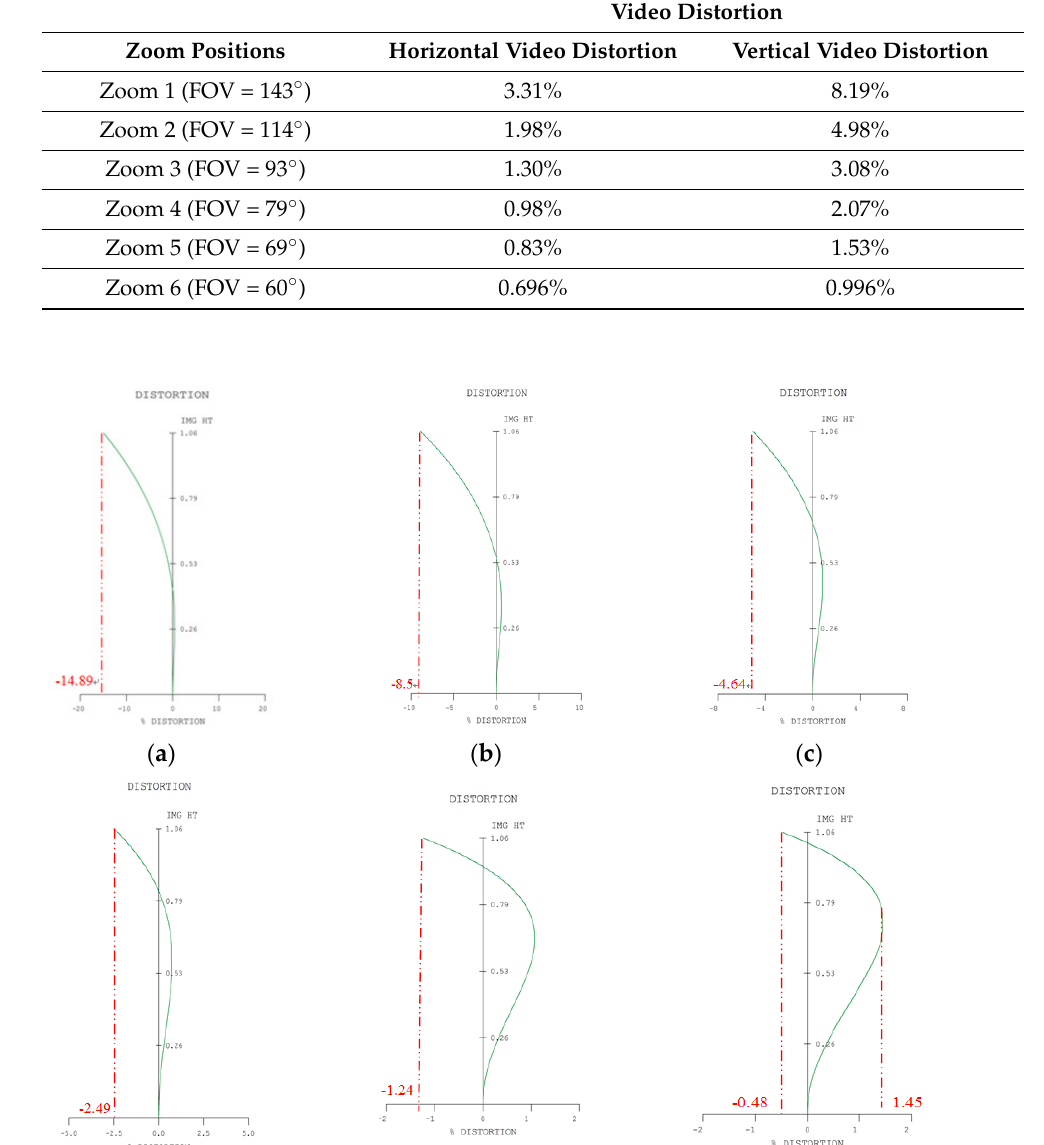
Table 3. Comparison of horizontal and vertical video distortion at different magnifications.